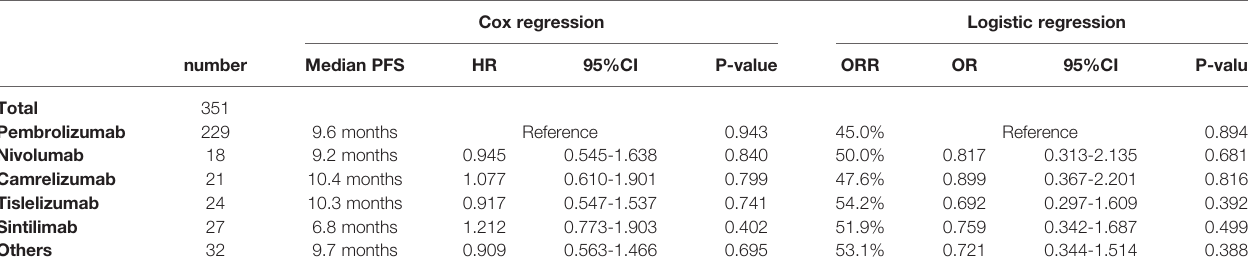
TABLE 2 | Differences in ef fi cacy between ICIs (all NSCLC patients). Cox regression Logistic